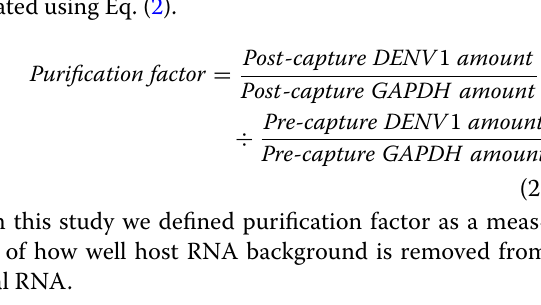
tional file 1: Table S3 and analyzed using QuantStudio Real-Time PCR Software v1.1 (Applied Biosystems). Each plate included a non-template control for each pair of primers to check for PCR contamination. Samples were quantified in duplicate and non-template controls in